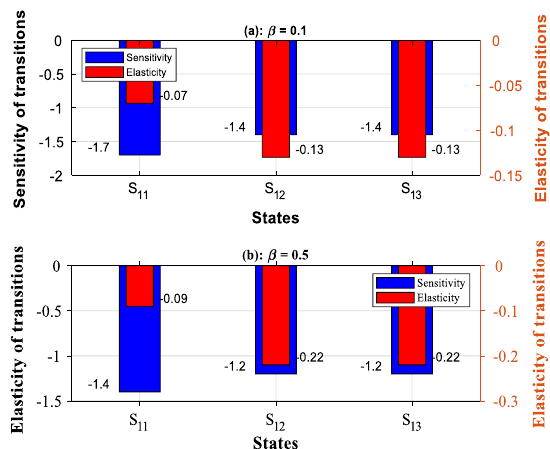
Fig. 19 Sensitivity and elasticity of system to CCF—low diagnostic